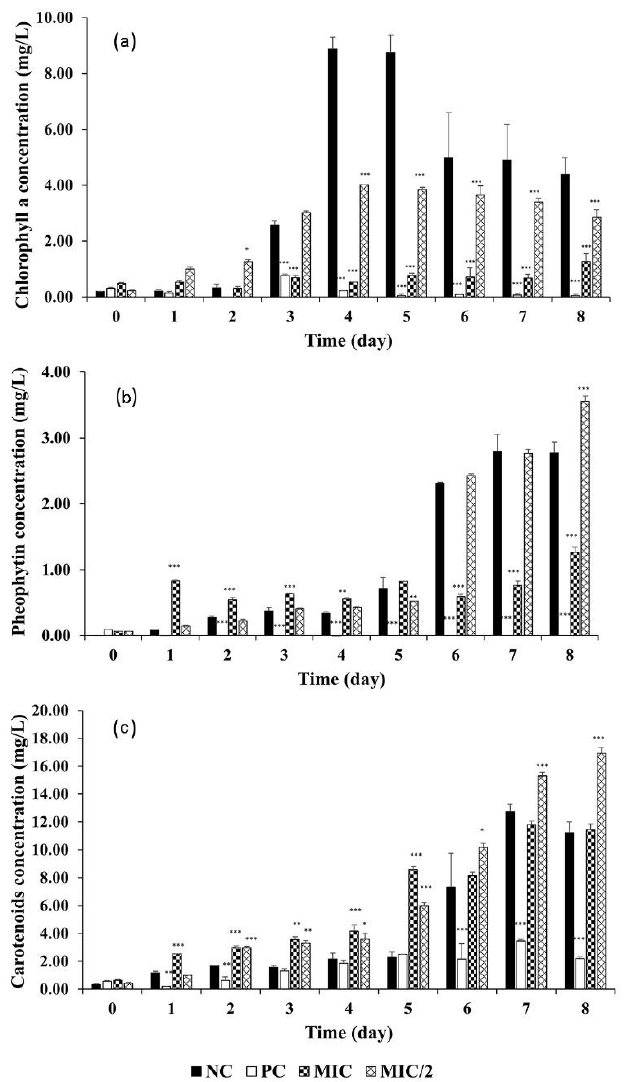
Figure 2. Effect of R. aquatilis aqueous extracts on the M. aeruginosa pigment contents. ( a ) Chl-a, ( b ) pheophytin, ( c ) carotenoids. Each value is the mean ± SD of three replicates. For the pigment concentrations, * p < 0.05, ** p < 0.01 and *** p < 0.001 indicate significant differences compared to the untreated culture (one-way ANOVA).